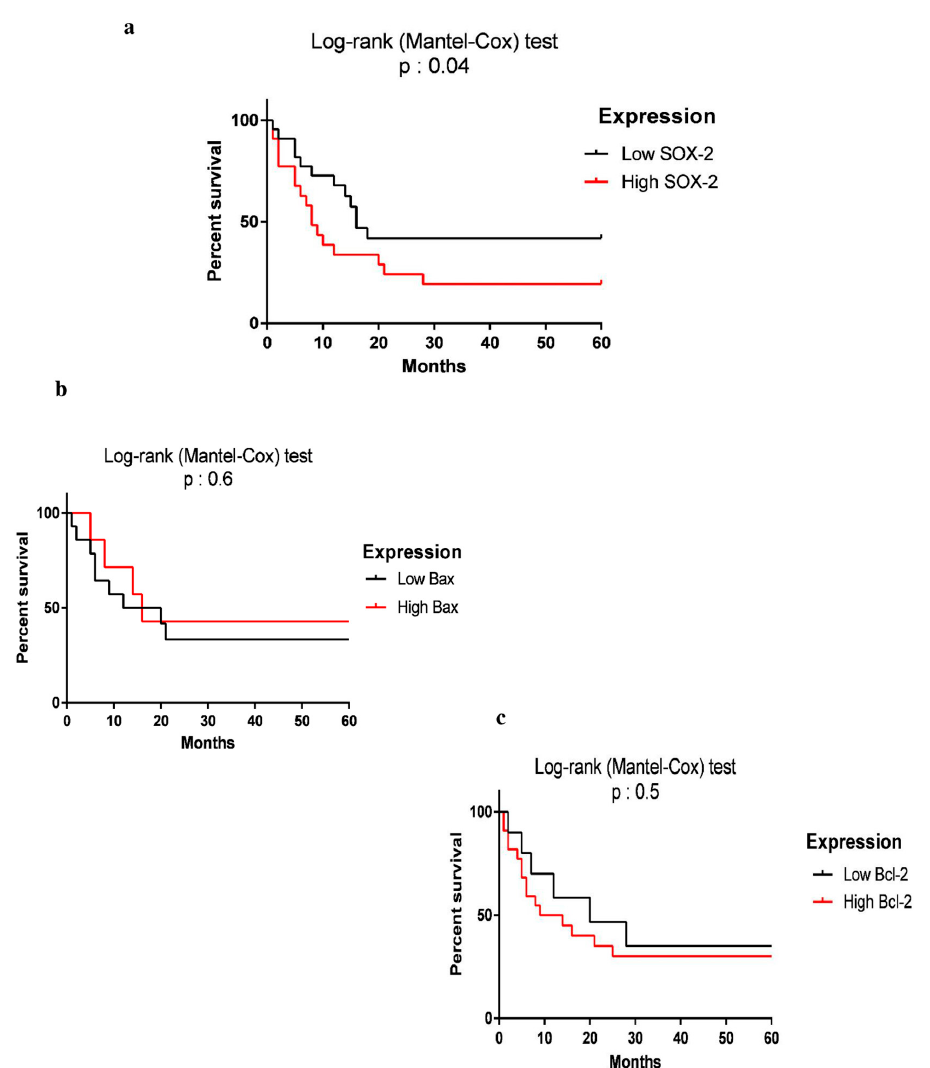
Figure 4. Kaplan–Meier plot for overall survival of HCC patients using the log-rank (Mantel–Cox) test; patients with higher expression of SOX2 had significantly lower 5-year survival rate compared to those with lower expression of SOX2 (log-rank: 3.082, p = 0.04). The median overall survival for low SOX2 was 10.5 months and for high SOX2 was 6.5 months. ( a ), Bax (log-rank: 0.1687, p = 0.6) and Bcl2 (log-rank: 0.3873, p = 0.5) expression was not correlated with the survival rate of HCC patients ( b , c